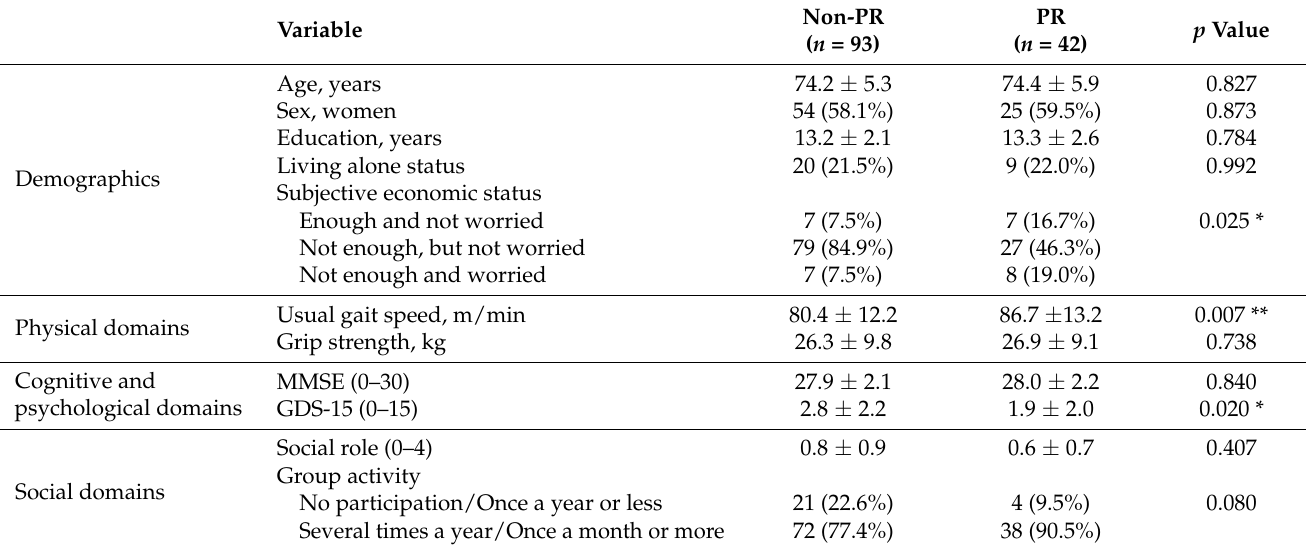
Table 1. Comparisons of characteristics.